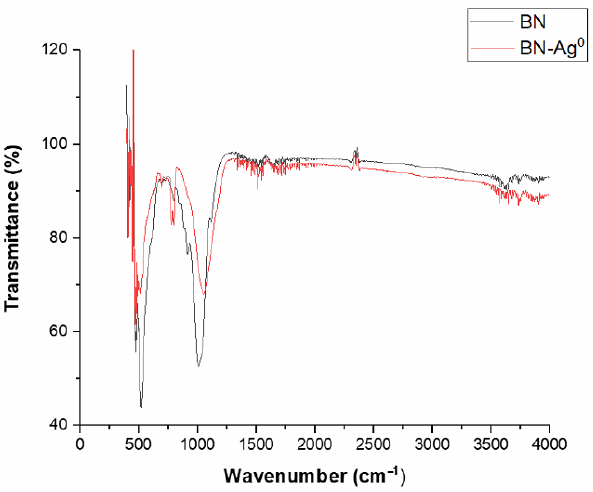
Figure 7. FTIR spectra of BN and of BN-Ag 0 .